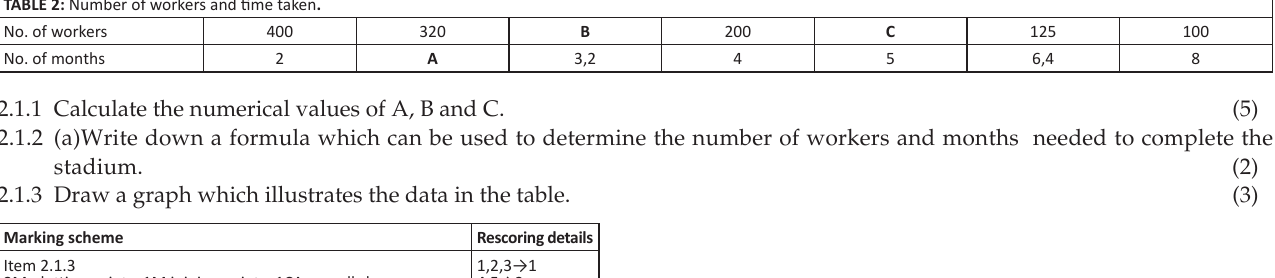
TABLE 2: Number of workers and time taken .